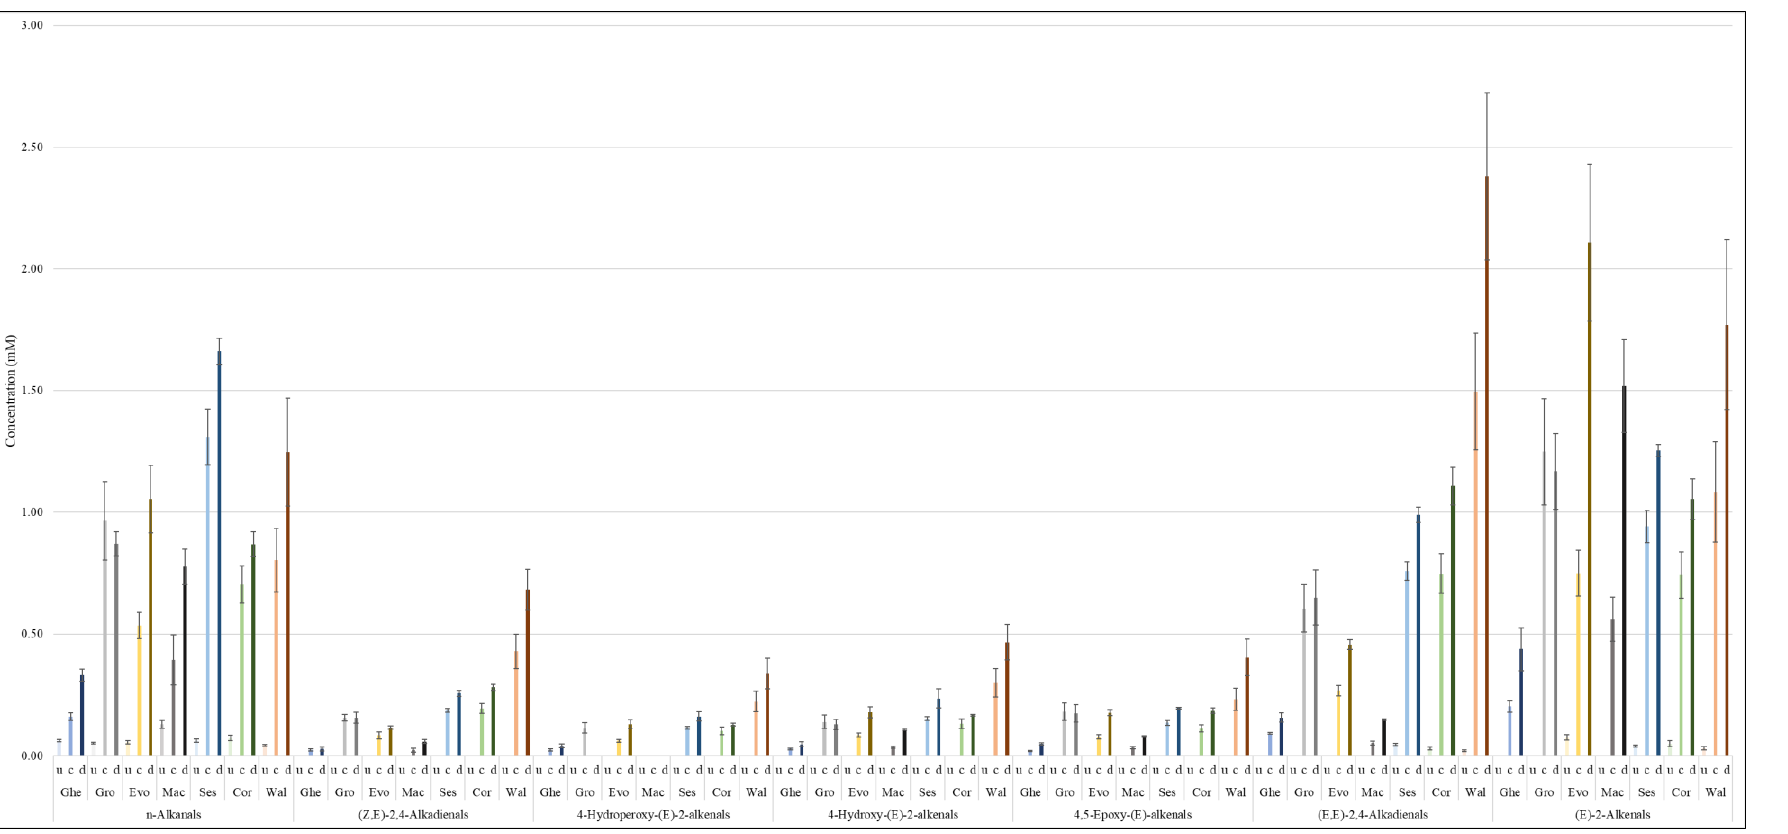
Figure 9. Evolutions of aldehydic LOPs (major types) in unheated and thermally stressed culinary oils exposed to continuous and discontinuous thermo-oxidation episodes at 180 °C for a 120 min period. Abbreviations: u — unheated oil; c — continuous thermo-oxidation episode; d — discontinuous thermo-oxidation episode; Ghe — ghee; Gro — groundnut oil; Evo — extra virgin olive oil; Mac — macadamia oil; Ses — sesame oil; Cor — corn oil; Wal — walnut oil. The values are presented as mean ± SD mM (mmol LOPs per 1.0 L volume of oil).